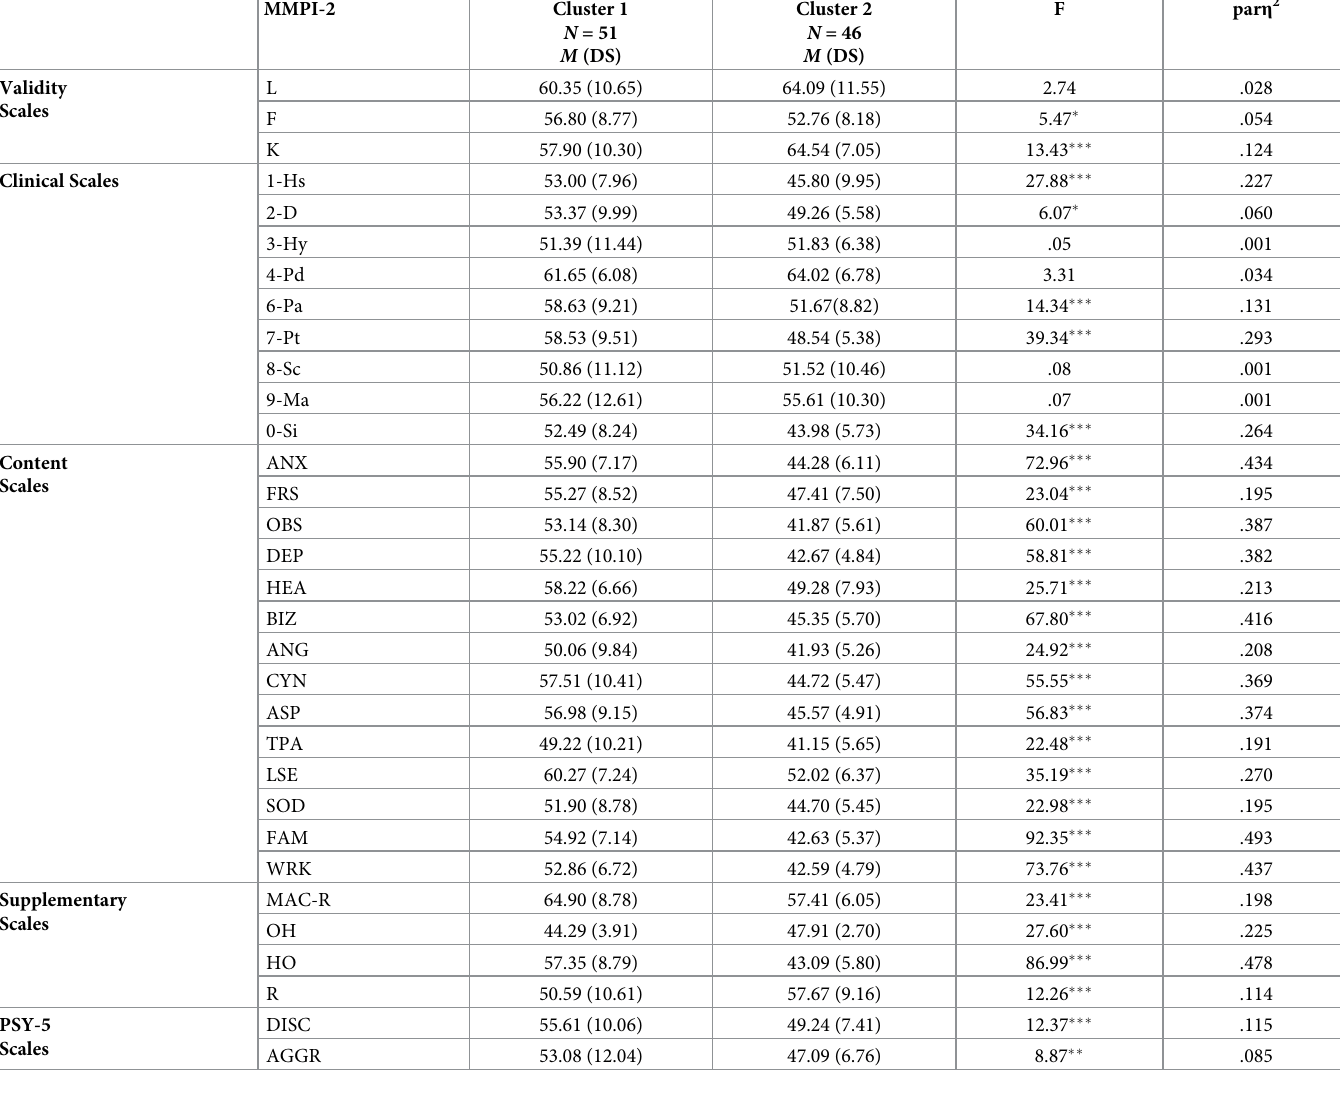
Table 4. Mean differences in MMPI-2 selected scales between cluster 1 and cluster 2 in